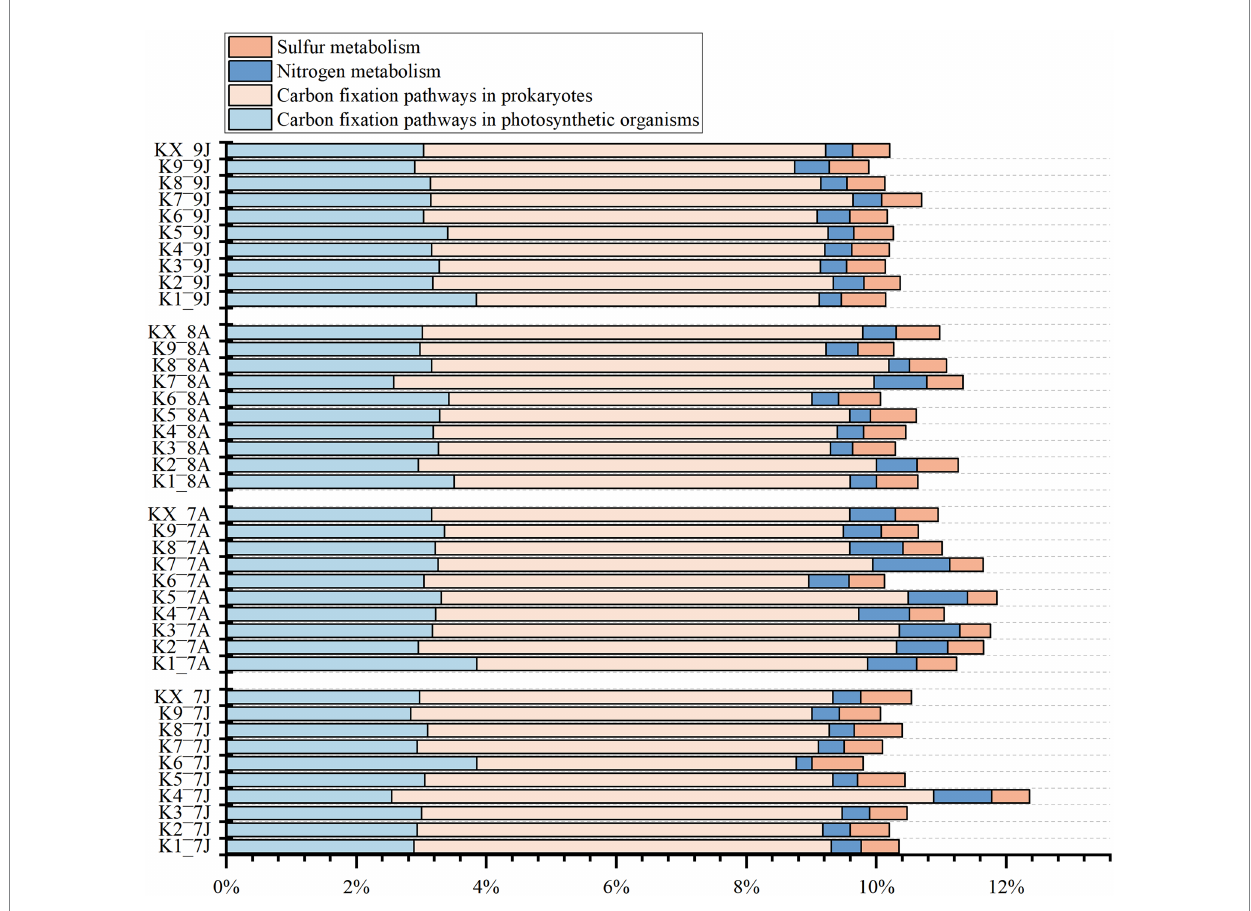
FIGURE 7 The stacked histogram of carbon, nitrogen, sulfur metabolic modules of Kyoto Encyclopedia of Genes and Genomes (KEGG) functional profiling at four sampling time (Jan-2017, Aug-2017, Aug-2018 and